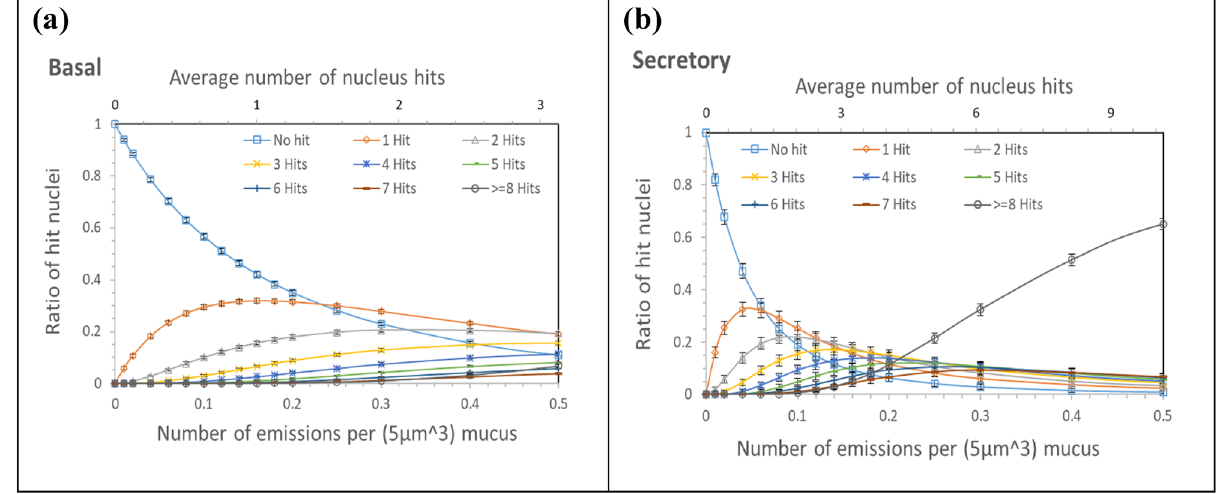
Figure 10. The ratio of nuclei that receive a specific number of hits due to varied numbers of alpha emissions from Po-218 and Po-214 radon progenies in a 5 µ m 3 mucosal layer for ( a ) basal and ( b ) secretory cells. Each bar indicates one standard deviation of the mean value.